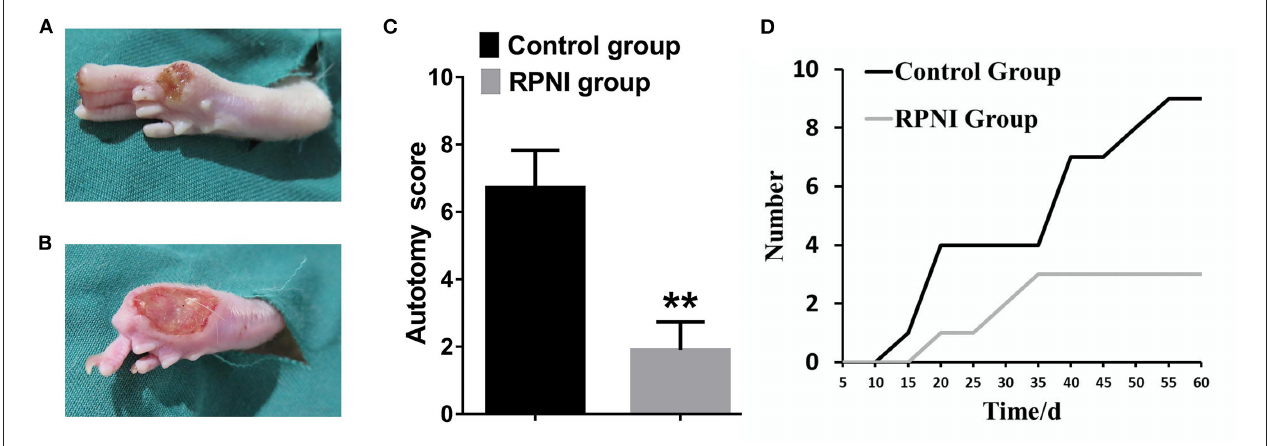
FIGURE 2 | (A) Representative pictures of autotomy behavior of rats in the RPNI group. (B) Representative pictures of autotomy behavior of rats in the control group. (C) Autotomy score of the control group and autotomy score of the RPNI group. (** P < 0.01). (D) Autotomy in the control group appeared earlier than that in the RPNI group, and the number of rats with autotomy increased with